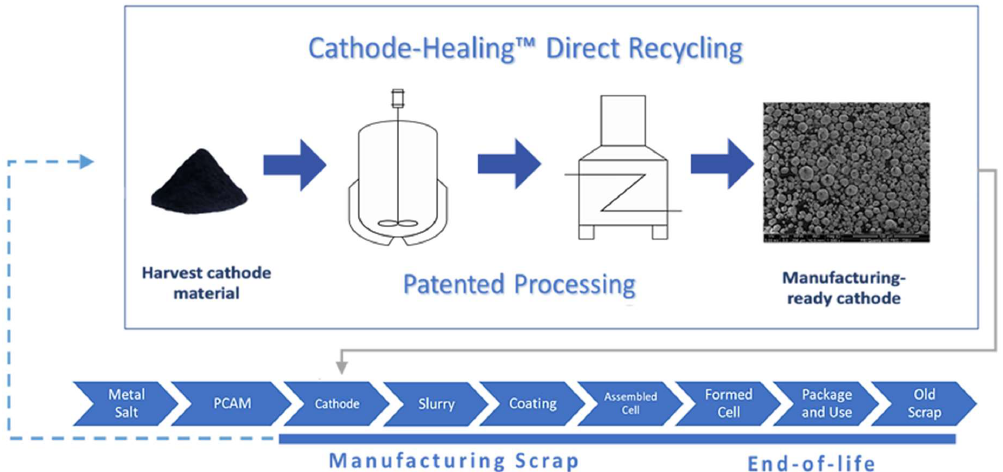
Figure 11. Cathode-Healing Direct recycling technology for spent LIBs by OnTo Technology (USA), adapted from [107].